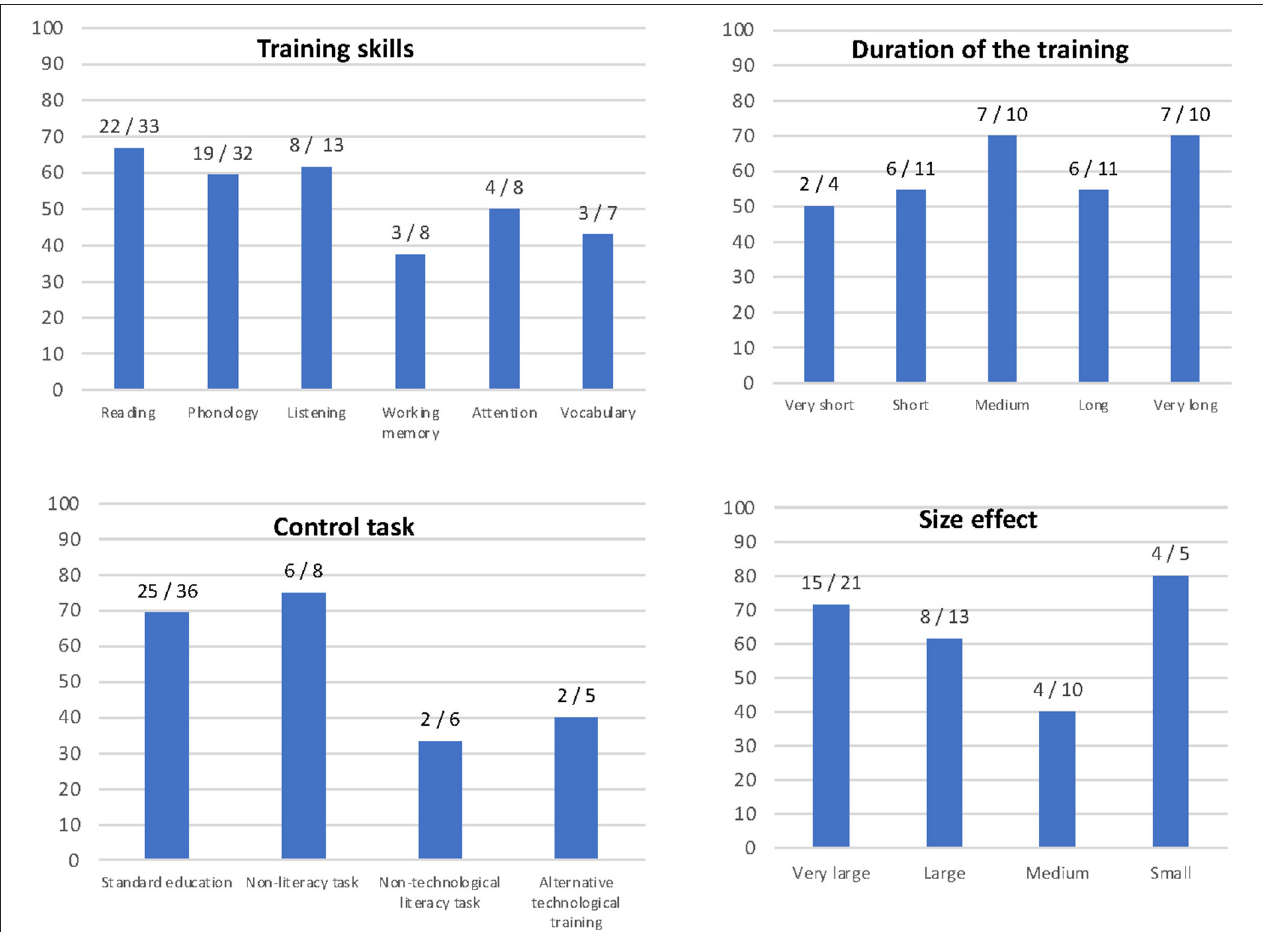
FIGURE 2 | Statistically significant studies: proportion of studies with statistically significant results in relation to four study characteristics: training skill, duration of the training, control task used and effect size that studies would have been able to consistently detect.